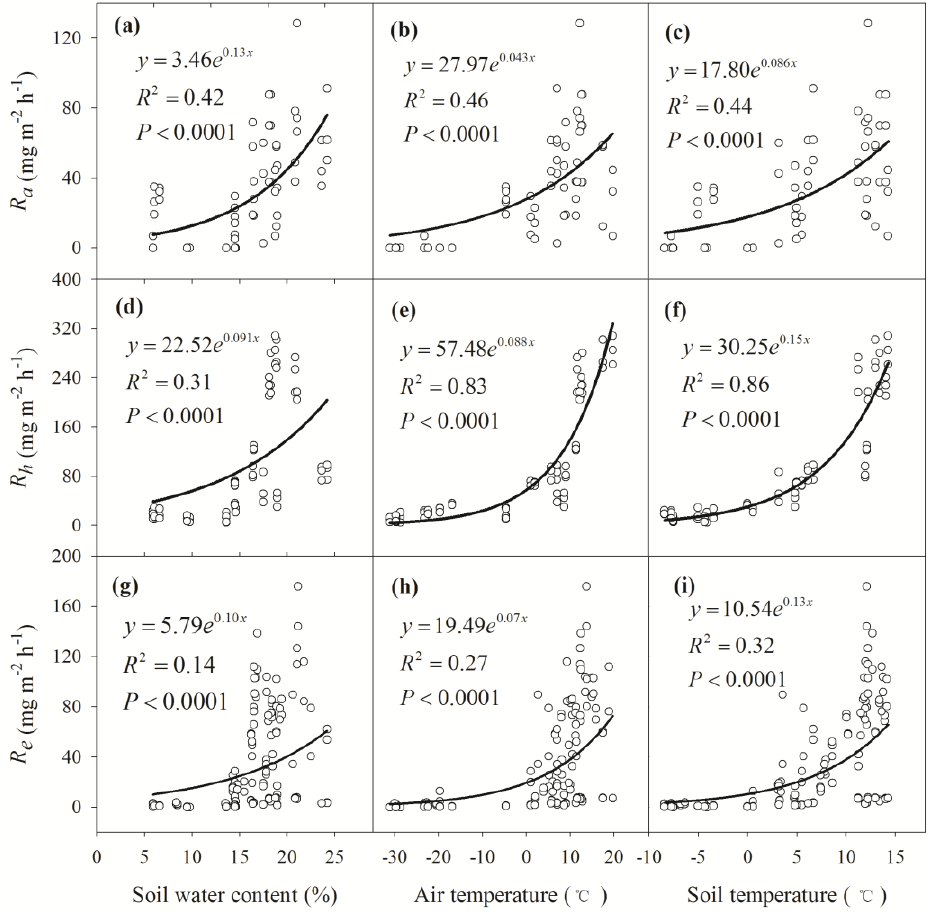
Fig. 4. Relationships between CO 2 fluxes ( R a , R h and R e ) and soil water content at 10cm depth ( a, d and g ), air temperature ( b, e and h ) and soil temperature at 10cm depth ( c, f and i Fig. 4 Relationships between CO cm depth (a, d and g), air temperature (b, e and h) and soil temperature at 10 cm depth 23 (c, f and i). 24